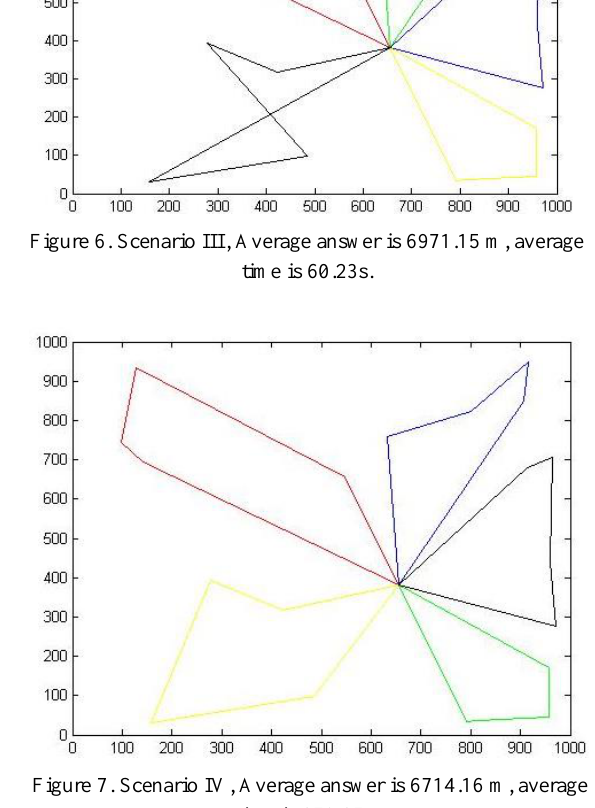
Figure 10. Scenario VII, Average answer is 9244.15 m, average time is 4.07s.